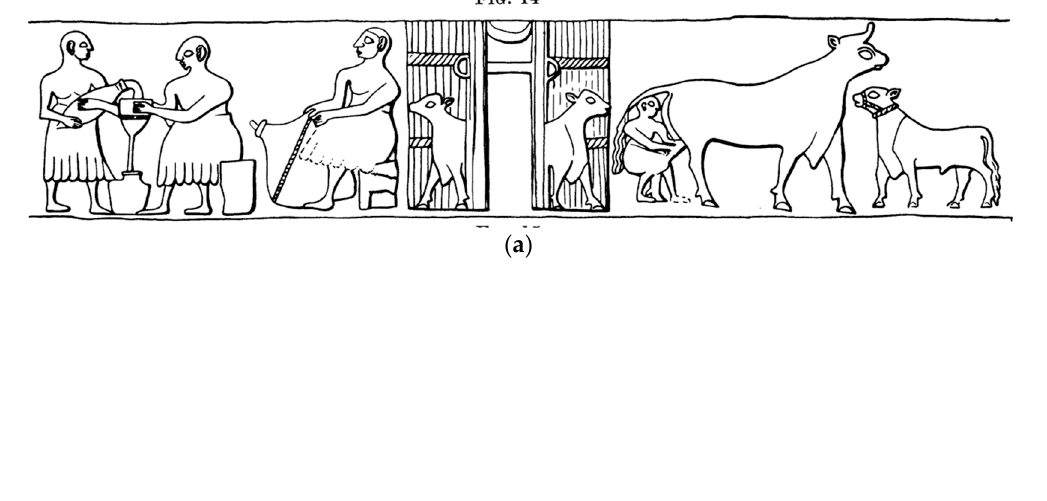
Figure 16. Babylonian kudurru -relief (11th century BCE), depicting the lunar halo: crescent enclosed within a sphere (Seidl 1989: Figure